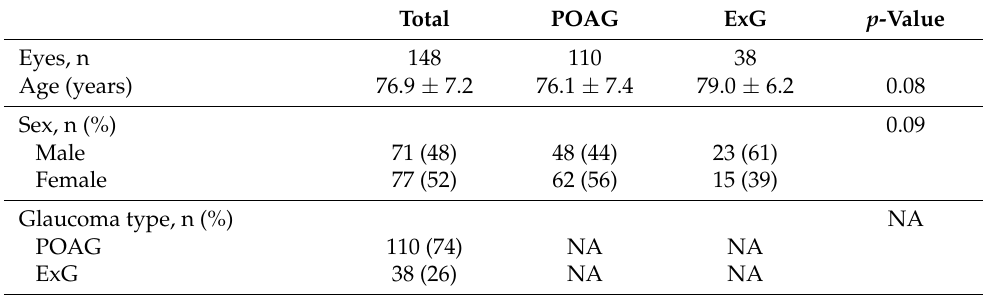
Table 1. Preoperative patient